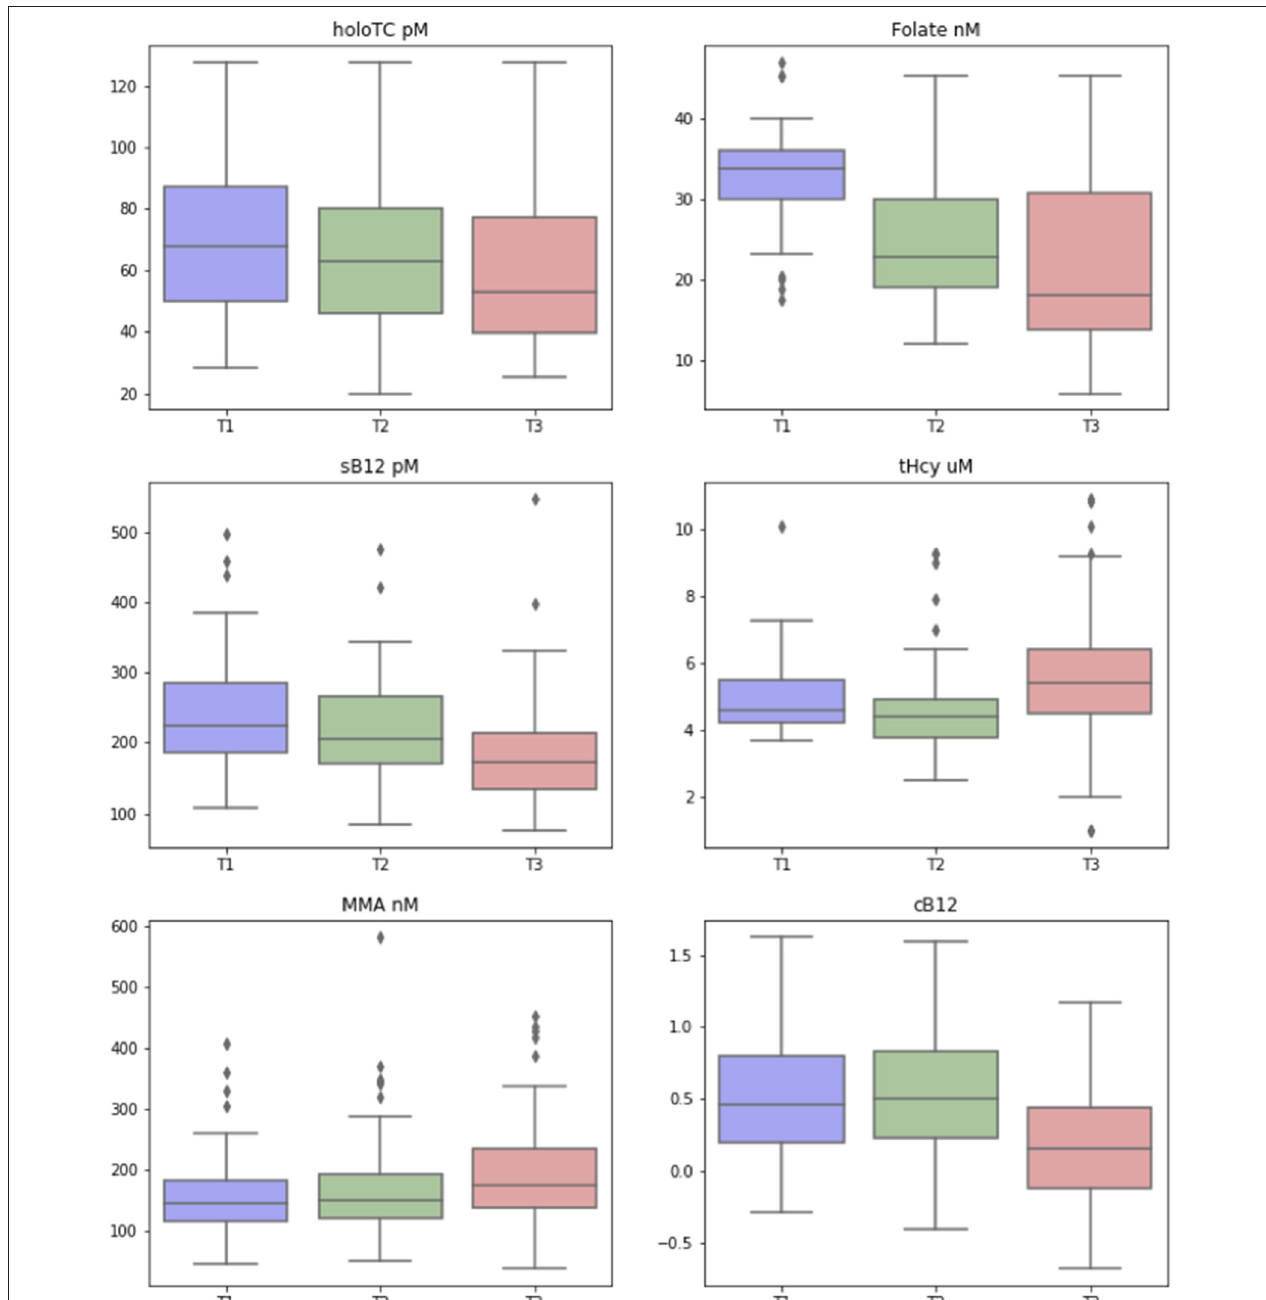
FIGURE 2 | Change in biomarkers of vitamin B12 status over the three trimesters of pregnancy. Box-and-whisker plots, showing how the biomarkers of vitamin B 12 [including transcobalamin (Holo TC, pmol/L), serum folate (Folate, nmol/L), serum B 12 (pmol/L), homocysteine (tHCy, micromol/L), methylmalonic acid (MMA, nmol/L), and combined B 12 (cB 12 )], changed across the three trimesters (T1, T2, T3) of pregnancy. The colored box represents the inter-quartile range (with median as the horizontal line), and the whiskers show the entire range of values considered to be within the homogeneous distribution, while diamonds represent the assumed outliers according to Tukey’s fences (median ± 2 × interquartile